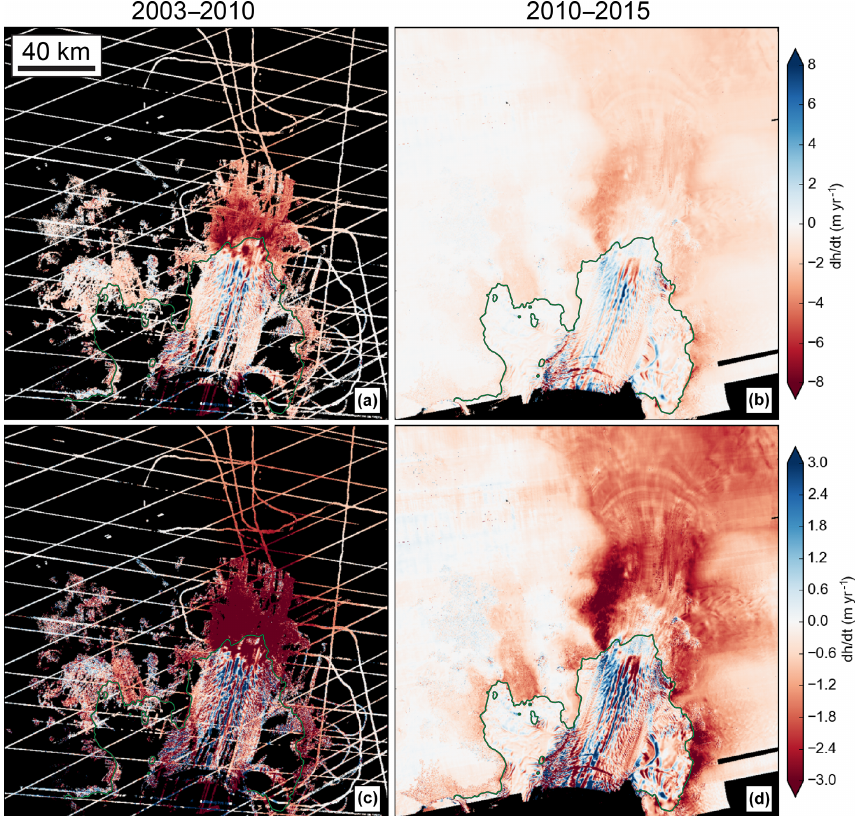
Figure 8. Long-term Eulerian d h/ d t trends for the PIG ice shelf and lower catchment: (a) 2003–2010 d h/ d t from ICESat, ATM/LVIS airborne altimetry, and SPIRIT DEMs and (b) 2010–2015 d h/ d t from WorldView/GeoEye DEMs, SPIRIT DEMs, and ATM/LVIS airborne altimetry. (c, d) The same data as in (a, b) but with enhanced contrast stretch to bring out details over the main